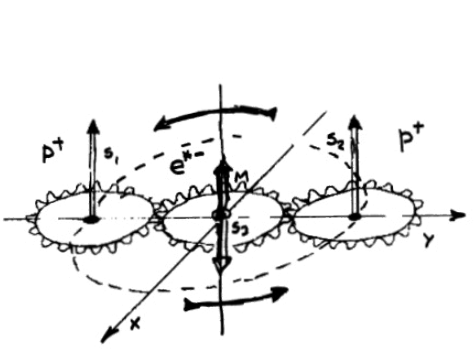
Figure 15: The “gear model” used by Santilli [25], page 180, to illustrate the prediction from the spin J = 1 that the deuteron is a three-body hadronic bound state of one D isoelectron and two isoprotons, with the individual couplings p − e and e − p being in singlet as necessary for stability. The spin J = 1 is then achieved from the “constrained D angular momentum” of the bound state studied in Sections II-3.5.3 and